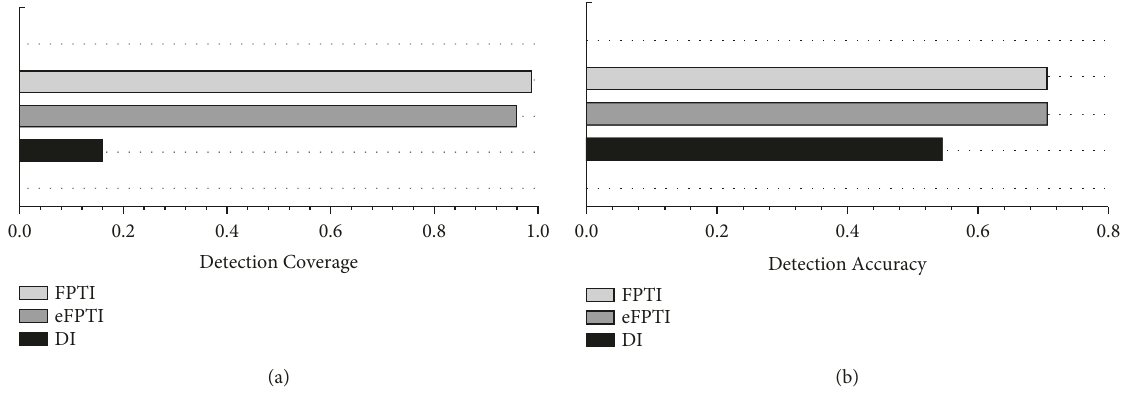
Figure 10: Reputation detection performance of the presented models (FPTI and eFPTI) vs. the direct interaction model (DI). (a) Results of detection coverage. (b) Results of detection